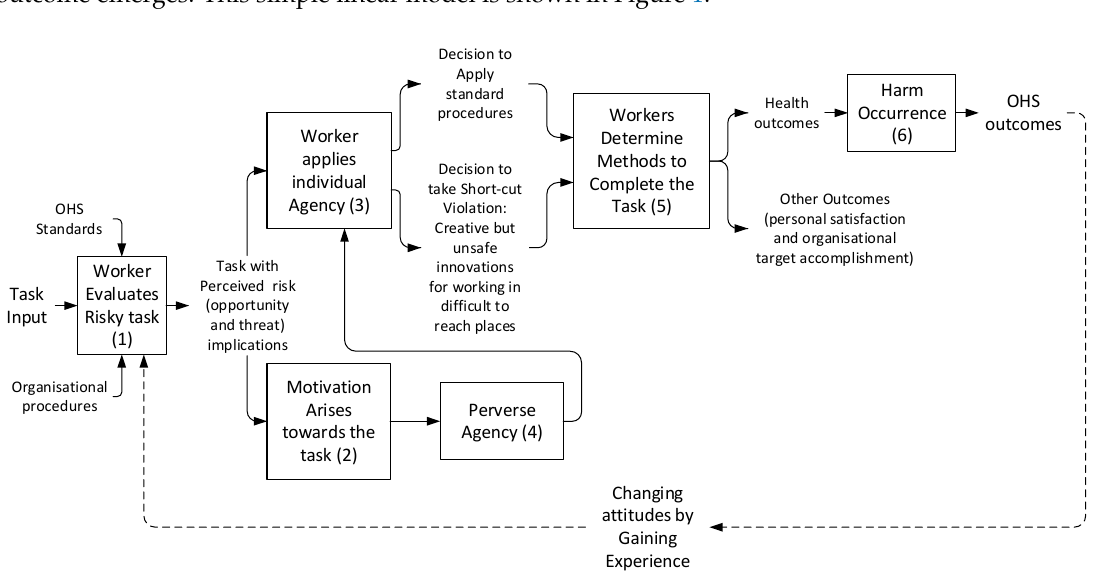
Figure 1. Risk, Agency, and Safety & Health (RASH) Model.